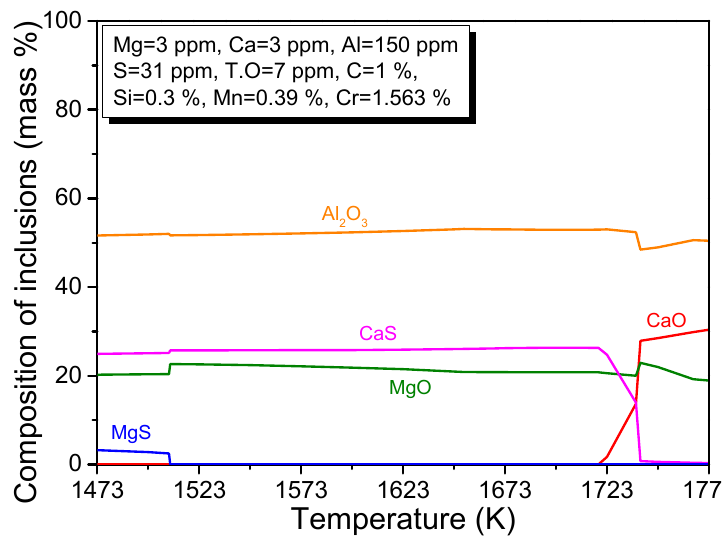
Figure 19. Evolution of the composition of inclusions in bearing steels at various temperature considering the steel with 7 ppm T.O.